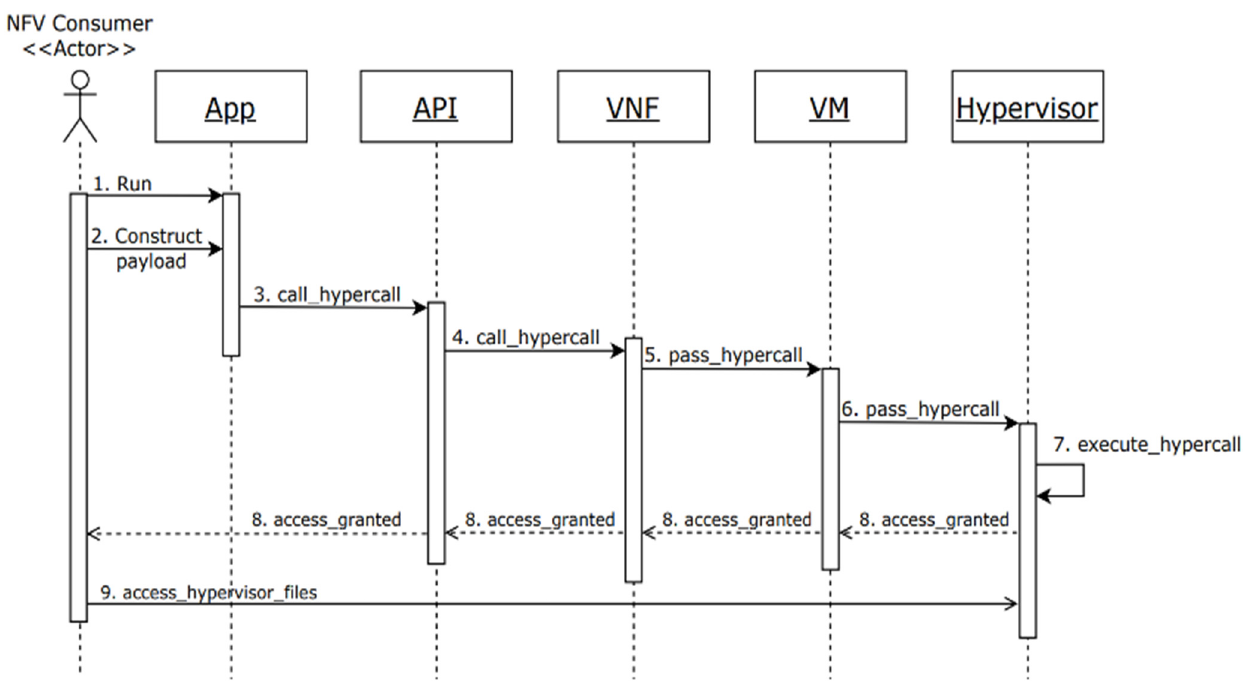
Figure 3. Sequence diagram for use case “Gain unauthorized access to hypervisor files by executing a malicious hypercall.”.